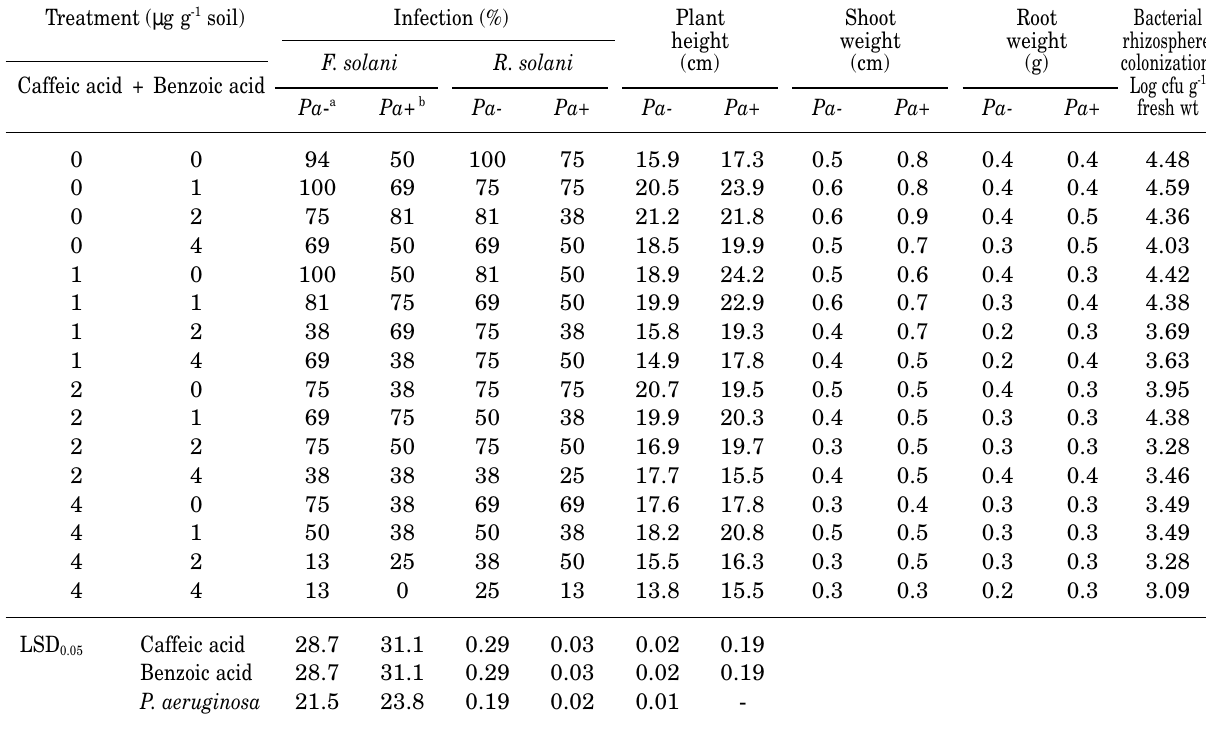
Table 2 . Effect of mixture of phenolic acids on Fusarium solani and Rhizoctonia solani , on growth of mungbean and on populations of Pseudomonas aeruginosa in the rhizoshere. Treatment ( µ g g -1